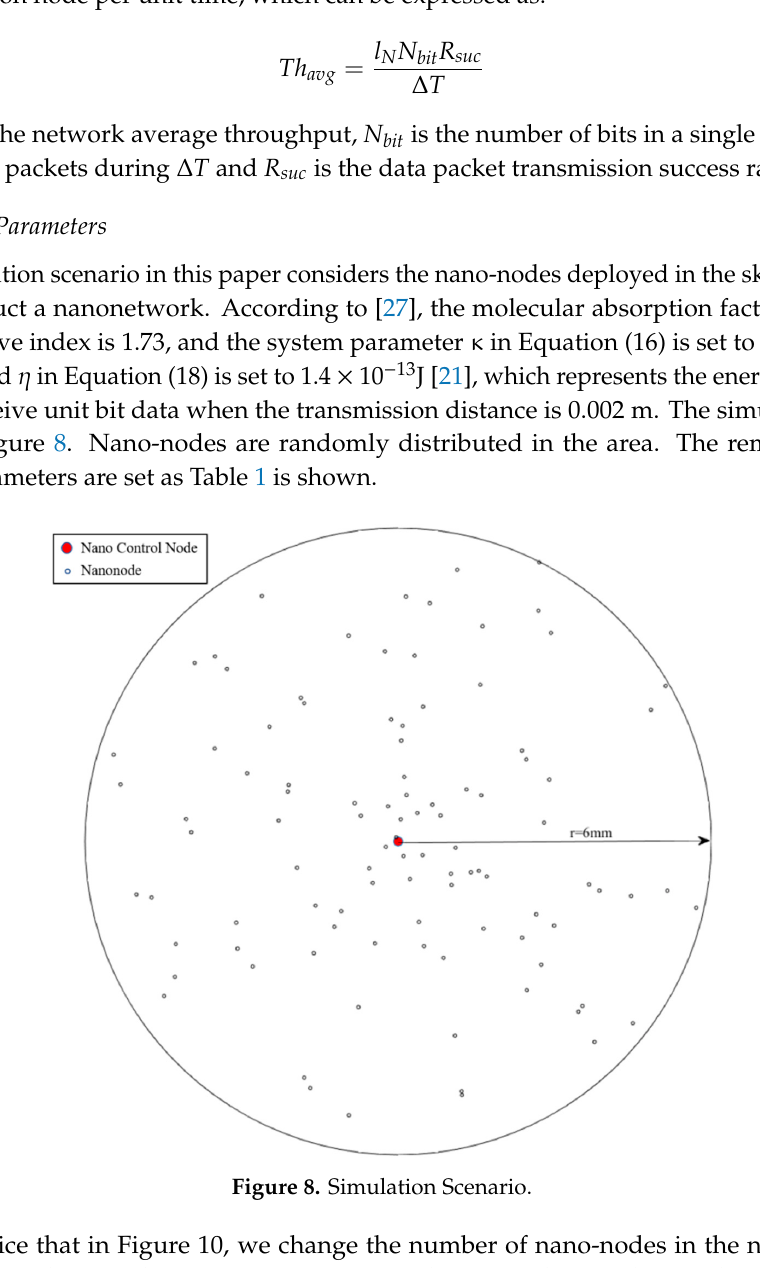
Table 1. Simulation parameter setting.